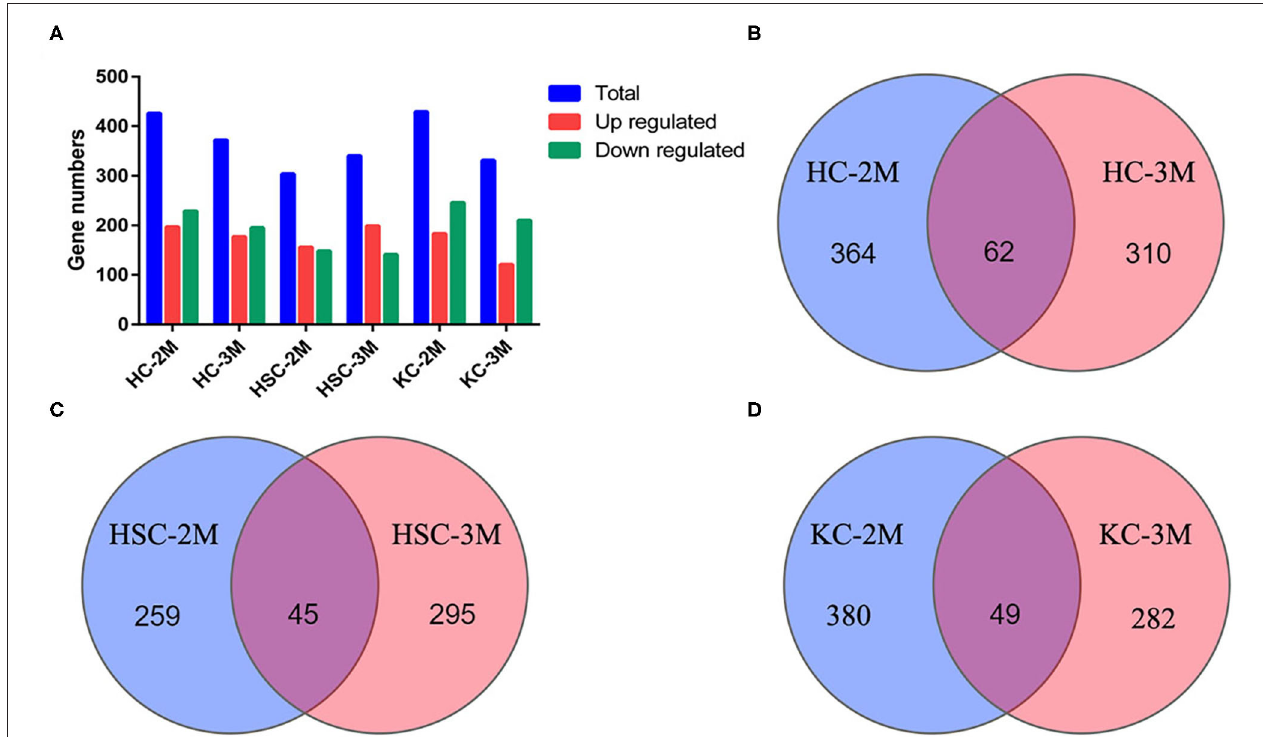
FIGURE 2 | Analysis of differentially expressed circRNAs (DECs) between control and infection groups in three kinds of cells. (A) Number of DECs in six groups. Blue bars represent total DECs, red bars represent upregulated circRNAs, and green bars represent downregulated circRNAs. (B) Venn diagrams of DECs in HC-2M and HC-3M. (C) Venn diagrams of DECs in HSC-2M and HSC-3M. (D) Venn diagrams of DECs in KC-2M and